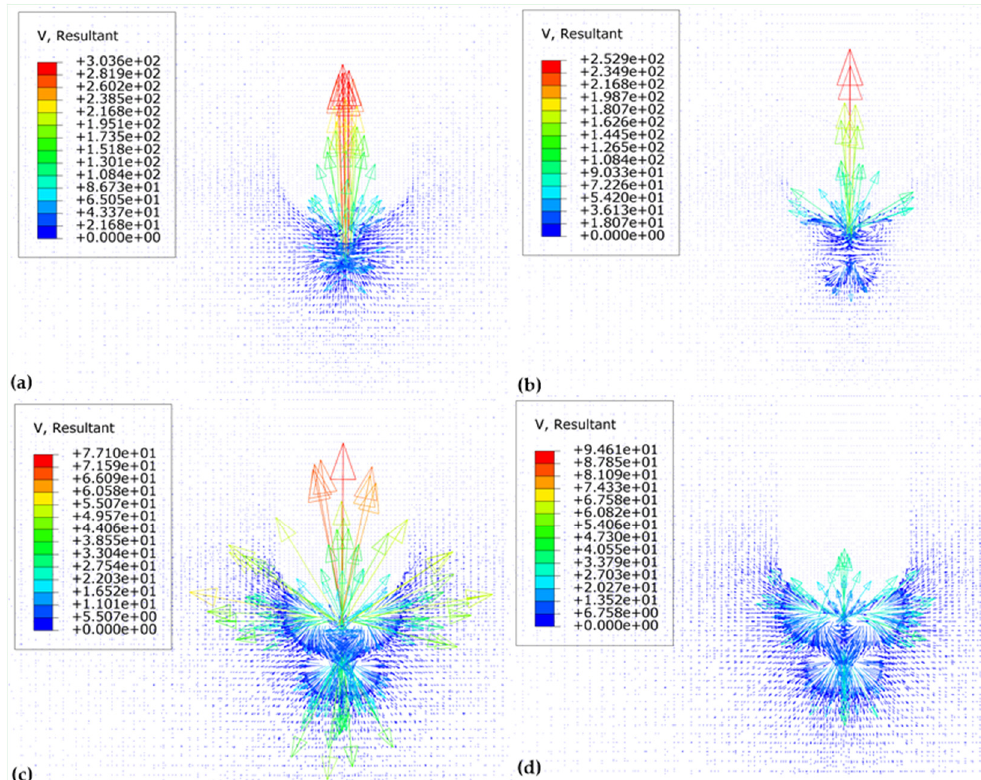
Figure 26. Velocity field in the bubble area during the collapse phase at: ( a ) t = 6.0 ms; ( b ) t = 6.1 ms; ( c ) t = 6.2 ms; and ( d ) t = 6.3 ms.